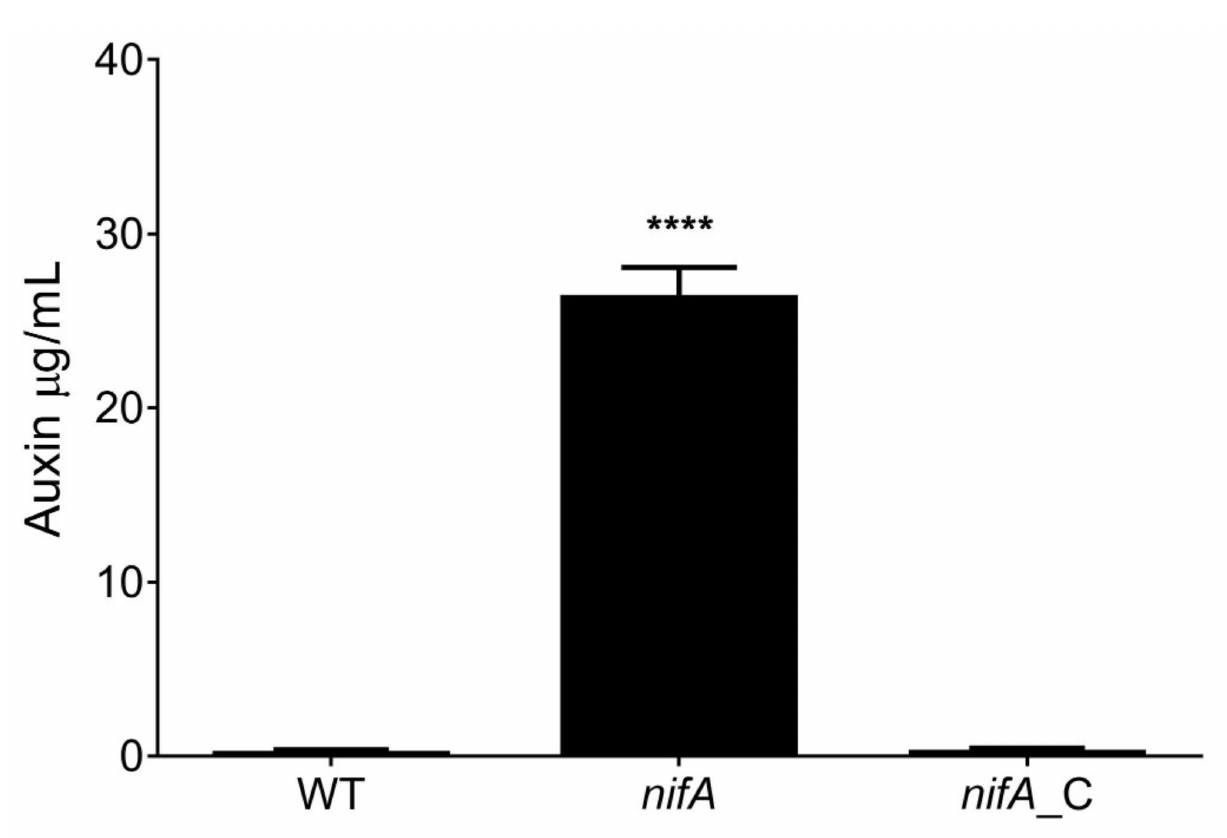
Figure 4. Auxinic compound production by P. phymatum STM815 (WT), nifA insertional mutant ( nifA ) and the complemented strain ( nifA_ C). Strains were grown in LB medium without salt for 16 h and the release of auxins was measured by colorimetry using indole − 3-acetate (IAA) as standard. The experiment was performed with three biological replicates. Error bars indicate error of the mean (SEM). Significance was calculated by ANOVA, Tukey’s test (****: p- value <